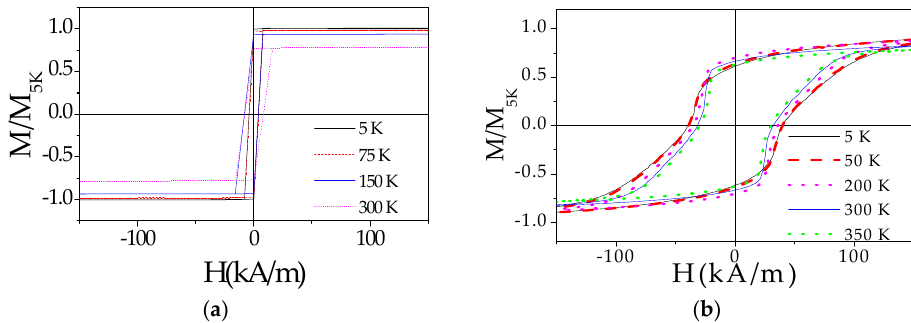
Figure 17. Hysteresis loops of as-prepared ( a ) and annealed at 500 °C for 1 h ( b ) Fe 50 Pt 40 Si 10 microwires measured at different temperatures. Adapted from [83].